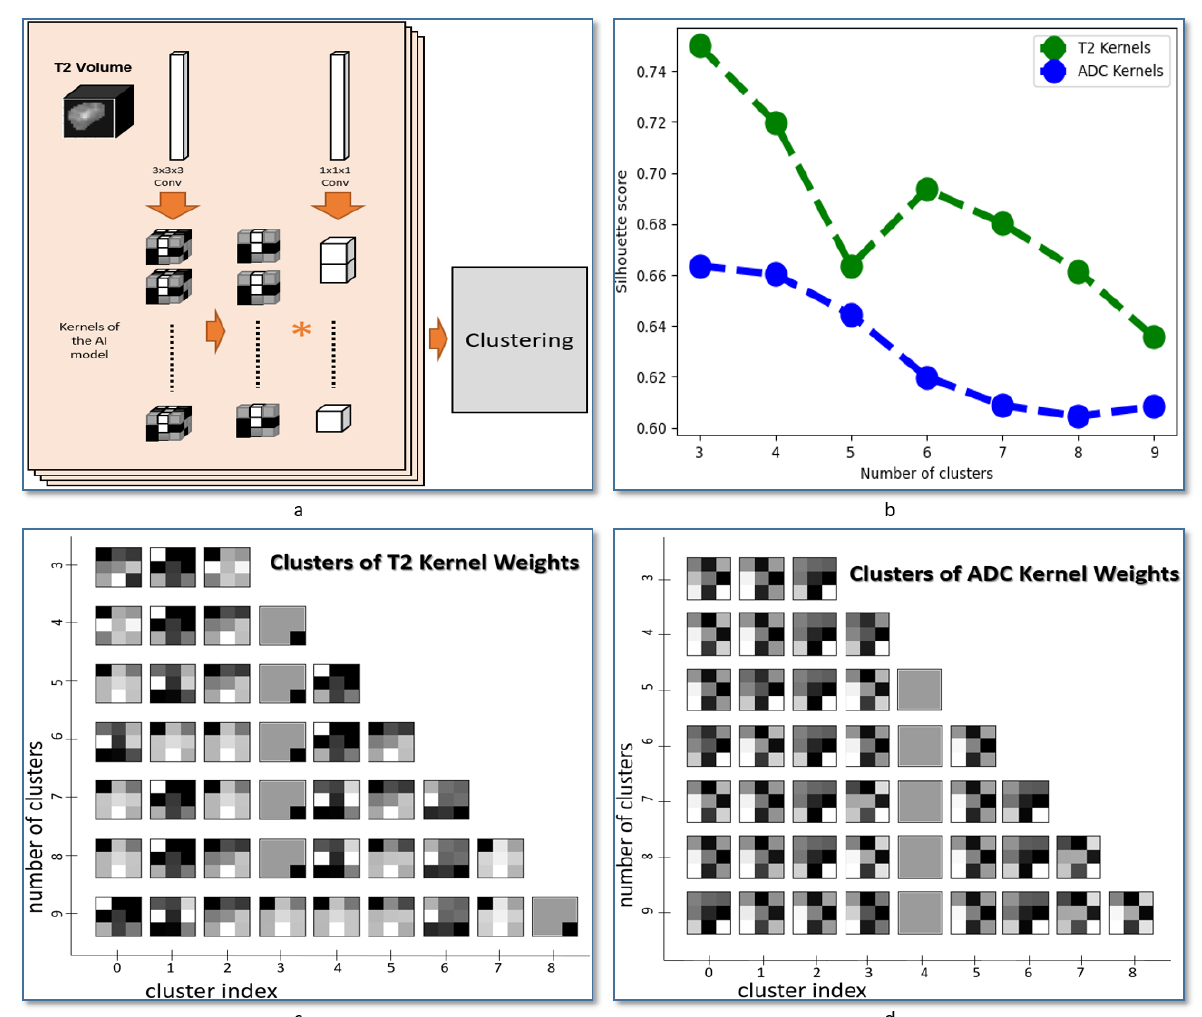
Figure 5. Analysis of the patterns extracted from the CNN after training phase. ( a ) Illustrative diagram of the process of extracting the kernels from the weights of each layer, and the processing of those kernels using a clustering technique (hierarchical agglomerative clustering) in order to analyze the patterns found in T2-weighted MRI images and ADC maps. ( b ) Evaluation metric of the clustering algorithm by computing Silhouette score while varying the number of clusters in the clustering algorithm. ( c ) Visualization of the results of our analysis on the features extracted from T2-weighted images. ( d ) Visualization of the results of our analysis on the features extracted from ADC maps. We can notice that the texture patterns that distinguish between malignant and benign thyroid nodules are having a degree of heterogeneity according to this